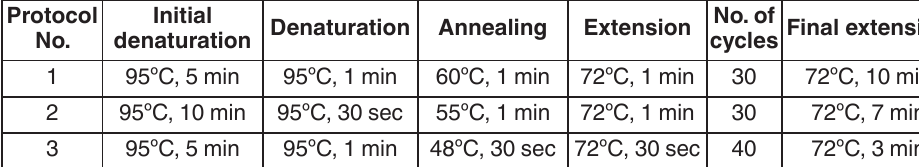
table 3. Antimicrobial Sensitivity pattern of the isolates isolate